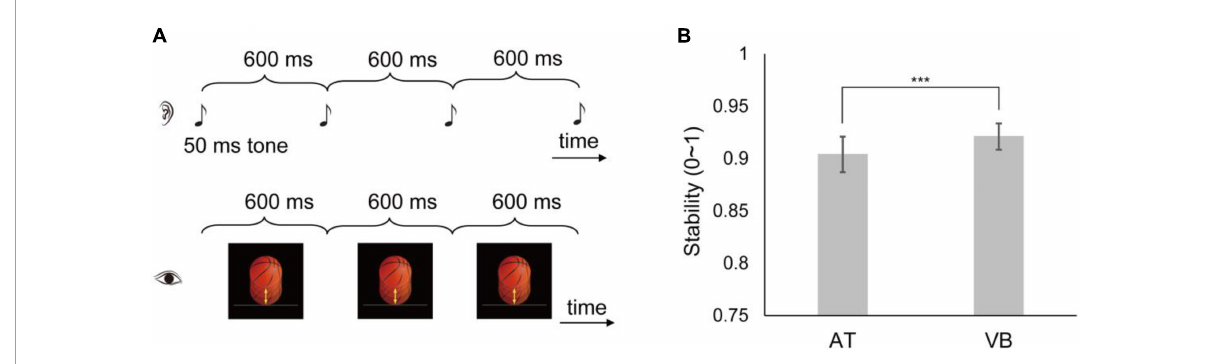
FIGURE1 Illustration of the experimental stimuli and synchronization stability results in the large sample-size data set. (A) The subjects tapped along with an isochronous sequence composed of an auditory tone (AT) (up: the AT sequence) or a visual bouncing ball (VB) (below: the VB sequence). Three cycles of the 600 ms inter-onset interval (IOI) sequences are shown. [The images are adapted from Huang et al. (2018)]. (B) Shown are the synchronization stabilities of the AT and VB sequences. The error bar indicates ± 95% CIs. ***Indicates p <